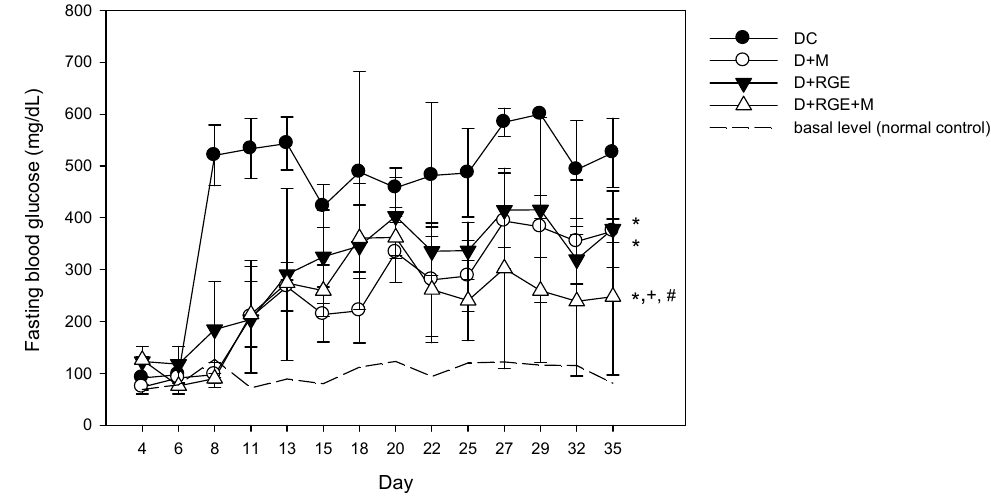
Figure 3. Effects of oral administration of metformin (M) and red ginseng extract (RGE) alone or combined on fasting blood glucose concentration of normal control (---), streptozotocin (STZ)-induced diabetic group ( ● , DC), diabetic rats treated with metformin ( ○ , D + M, 50 mg/kg/day), diabetic rats supplemented with RGE ( ▼ , D + RGE, 2 g/kg/day), and diabetic rats treated with metformin and RGE ( ∆ , D + RGE + M). Data points are means ± SD of four different rats per group. * p < 0.05 compared with DC group; + p < 0.05 compared with D + M group; # p < 0.05 compared with D + RGE group using two-way ANOVA test.